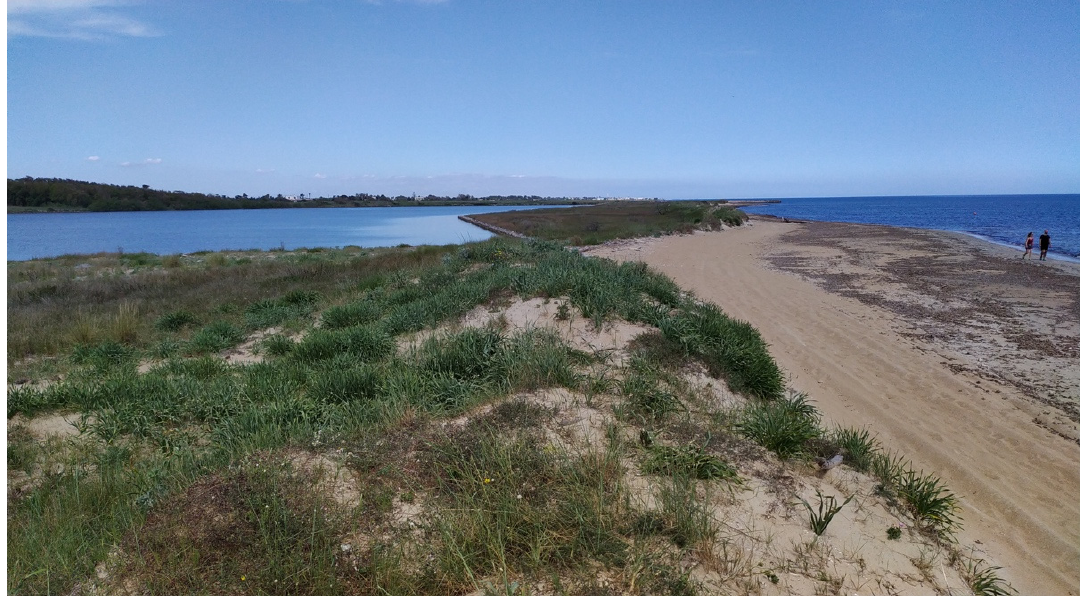
Figure 2. General view of the Acquatina di Frigole lagoon looking to the northwest.